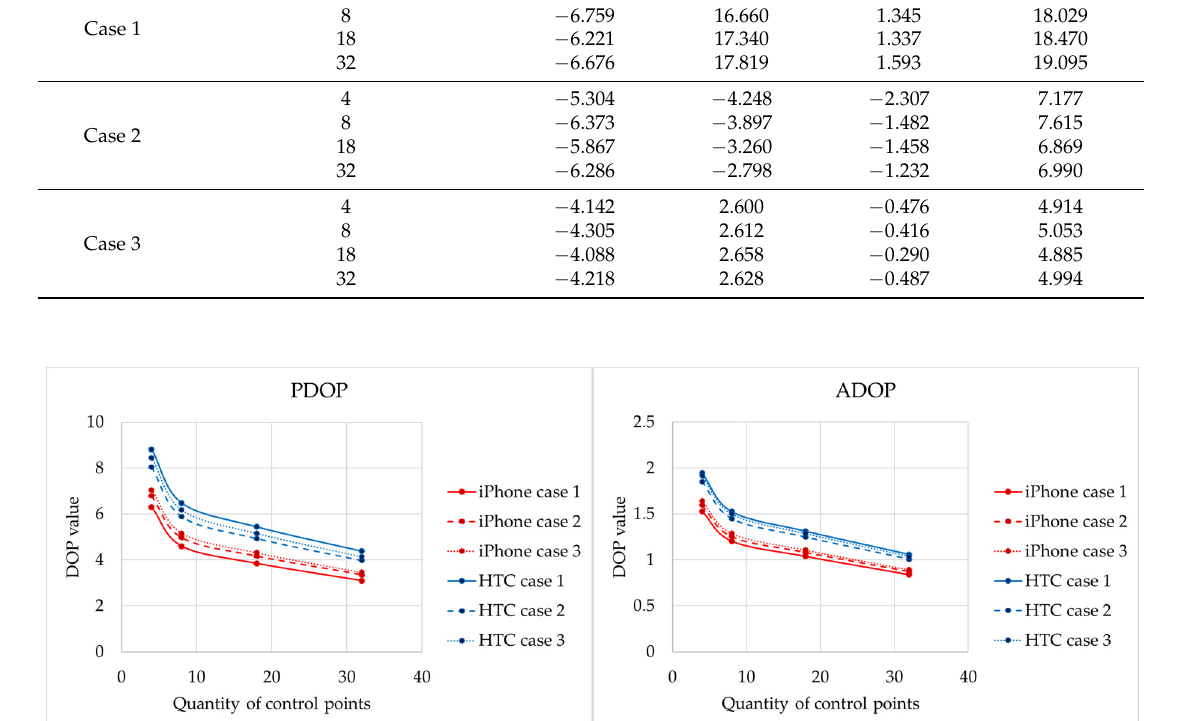
Figure 11. The distribution of control points for analysis of their optimal weights. Tables 6 and 7 show the position RMSEs for two scenarios using two smartphones. The three images were taken by each smartphone at different times. The first row shows the power of distance, which is the weight of each control point that depends on its distance from the principle point. If the power is positive, it means a larger weight of the image point with longer distance between itself and the principle point; if the power is negative, it means a smaller weight of the image point with a longer distance between itself and the principle point. Figure 12 shows quartic polynomial fitting of the optimal weight corresponding to different powers of distance and the normalized position error